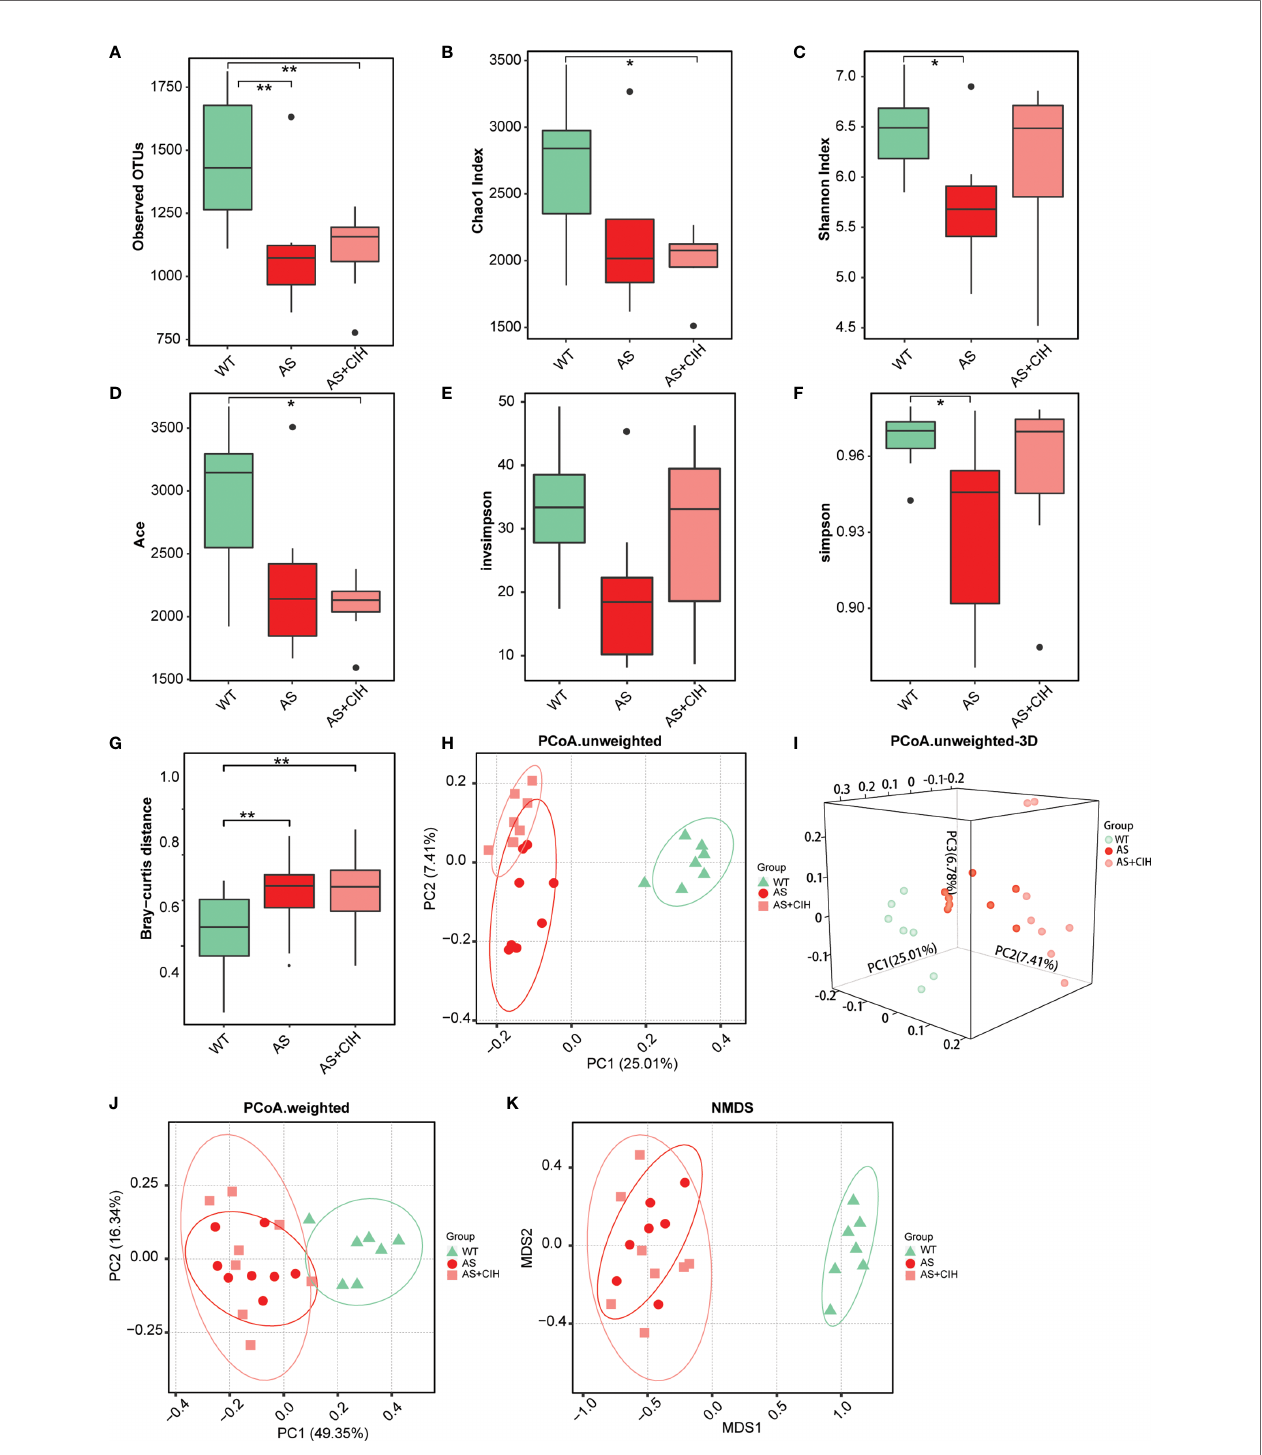
FIGURE 2 | Gut microbial diversity within-sample ( a ) and between-sample ( b ) in CIH treated apoE -/- mice fed with HFD. (A) Number of observed OTUs in control (WT), AS and atherosclerotic mice with CIH (AS+CIH). b-f. Parameters of a -diversity at the genus level, including Chao index (B) , Shannon index (C) , Ace (D) , invsimpson (E) and simpson (F) among groups. (G) Bray-curtis distance, parameters of b -diversity in the WT, AS and AS+CIH groups. The boxes represent the inter quartile ranges, whereas the inside line represent the median and the points are outliers. * P value < 0.05, ** P value < 0.01, Kruskal-Wallis. (H, J) Unweighted (H) and weighted (J) unifrac PCoA plots of samples from groups at the genus level. (I) 3D version of the unweighted unifrac PCoA plots. (K) NMDS plots of each sample based on abundances of the genera. n=7 for WT, and n=8 for AS and